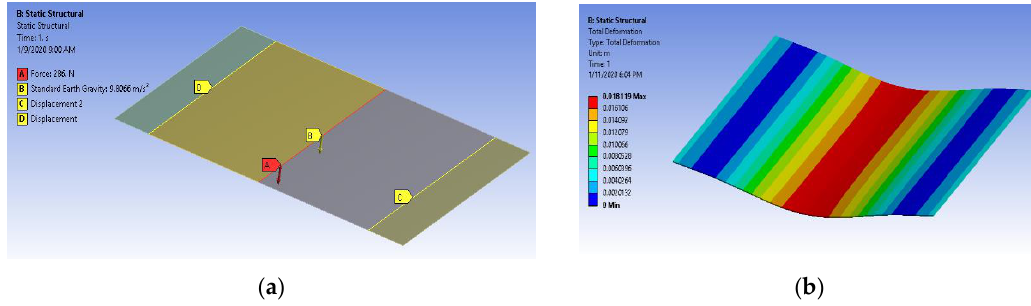
Figure 15. Simulation of the composite plate using ANSYS software. ( a ) The simulation, ( b ) Total Figure15. SimulationofthecompositeplateusingANSYSsoftware. ( a )Thesimulation,( b deformation.